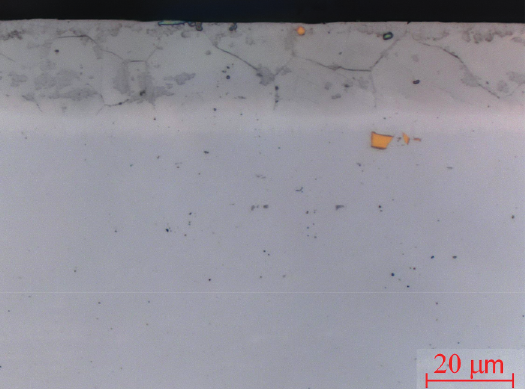
Figure 3: Cross-section of a nitrided sample, treatment time 20 min, nitriding temperature 510°C, sample bias – 500 V, sample current density 2.0 mA/cm 2 , layer microhardness 9.0